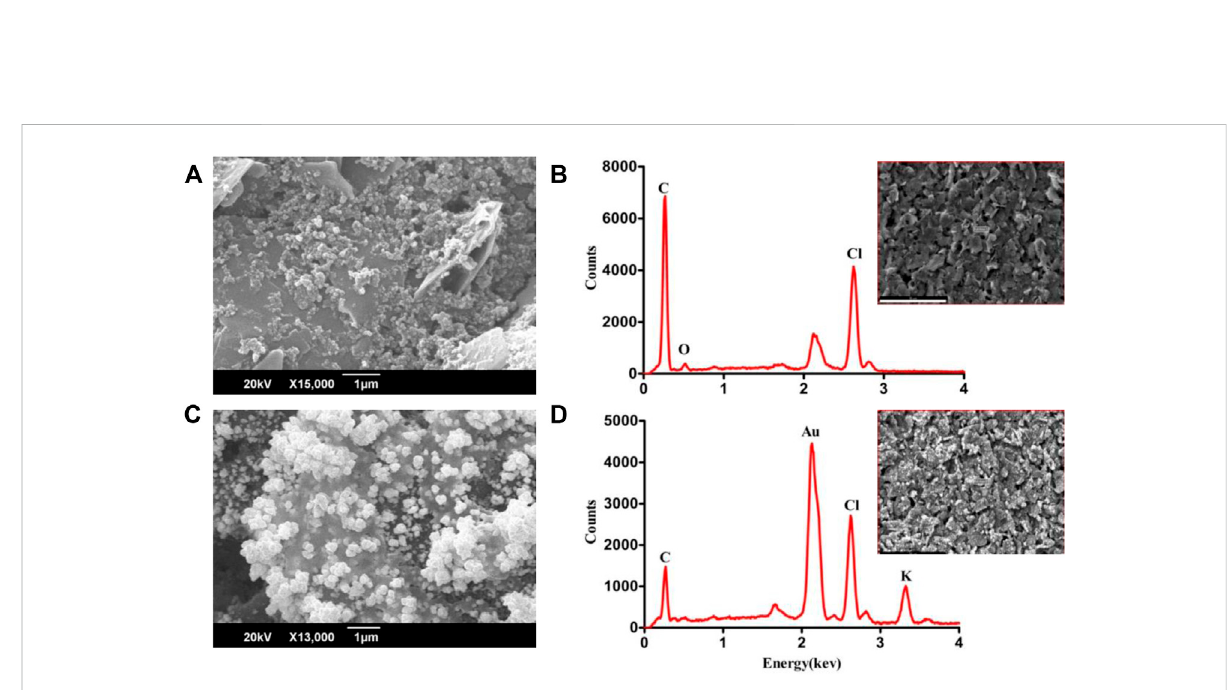
FIGURE 2 SEM and EDX analysis of carbon SPE (A,B) and electrodeposited gold SPE (C,D) .